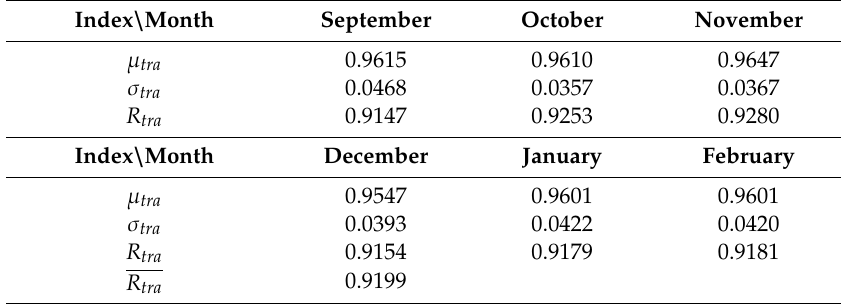
Table 6. The travel-time reliability of the air tra ffi c network (TTRN) of the US air tra ffi c